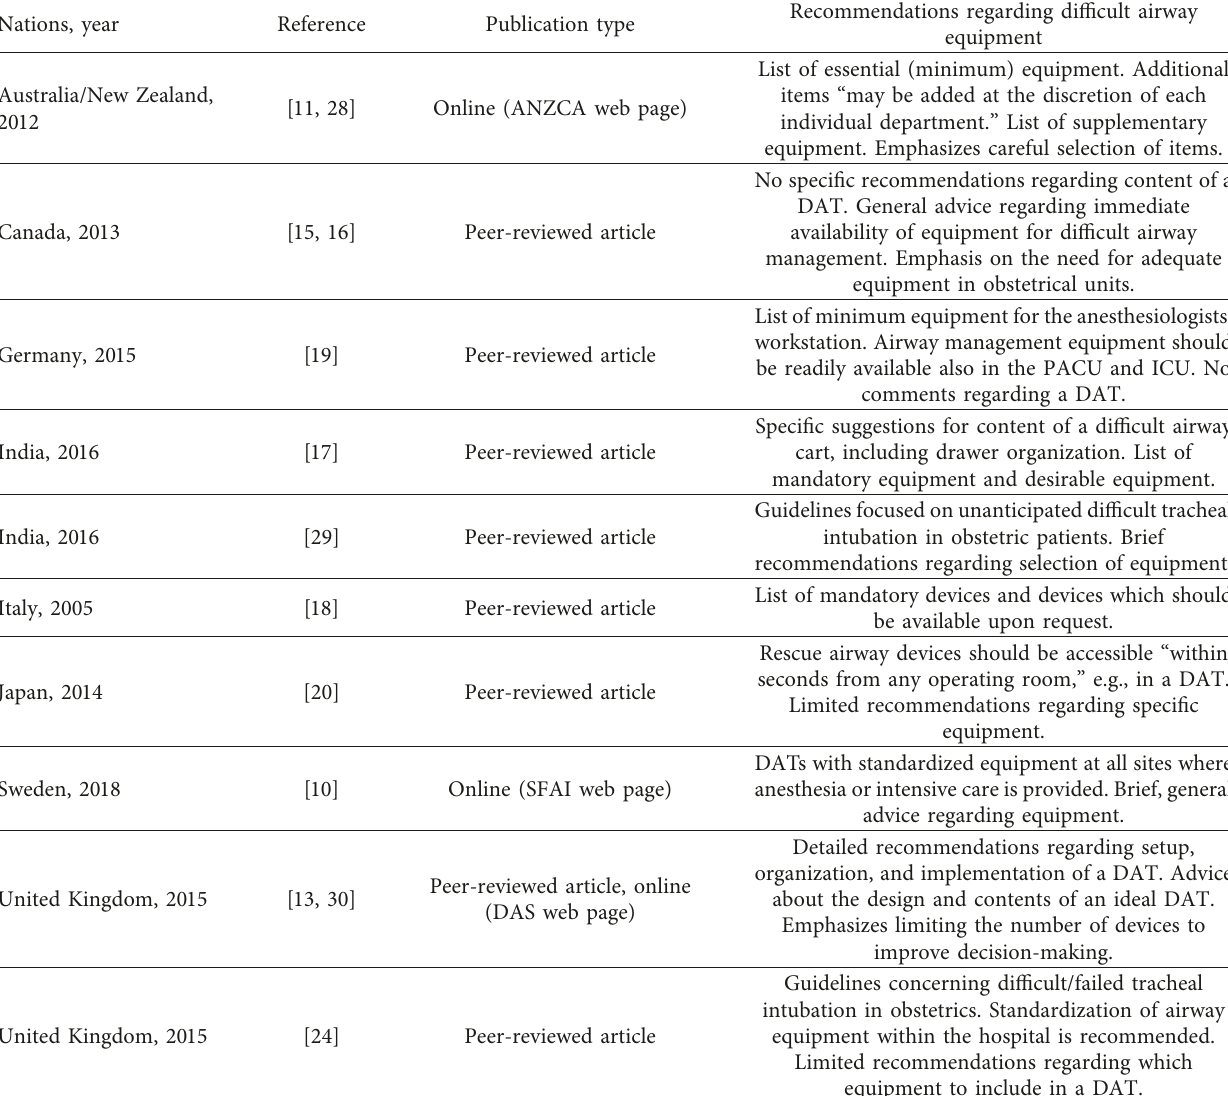
Table 1: National and international guidelines: general recommendations regarding difficult airway equipment.